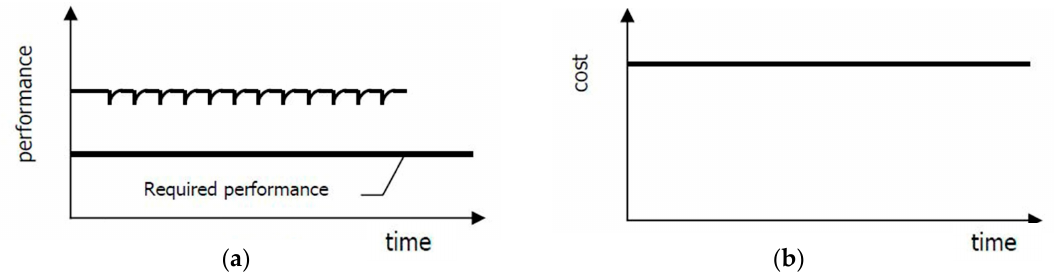
Figure 9. Performance ( a ) and cost ( b ) over time of a structure made with self-regenerating material (concrete). Interest and inflation not considered Error! Reference source not found.